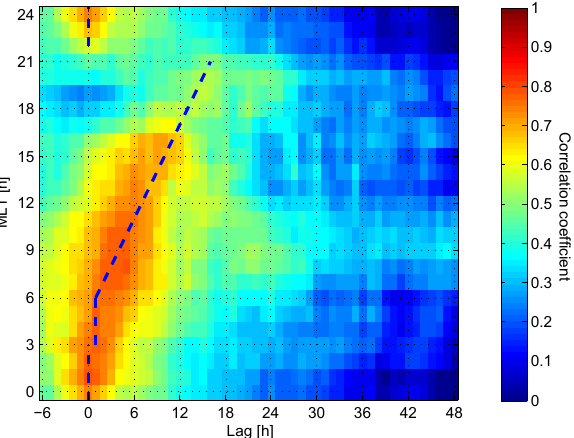
Figure 12. Cross-correlation between VAP PP_ N e position and the SSFAC index as a function of MLT.